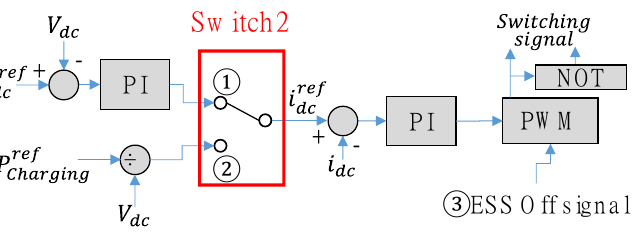
Figure 3. Control block diagram of the bidirectional DC/DC converter of the ESS.